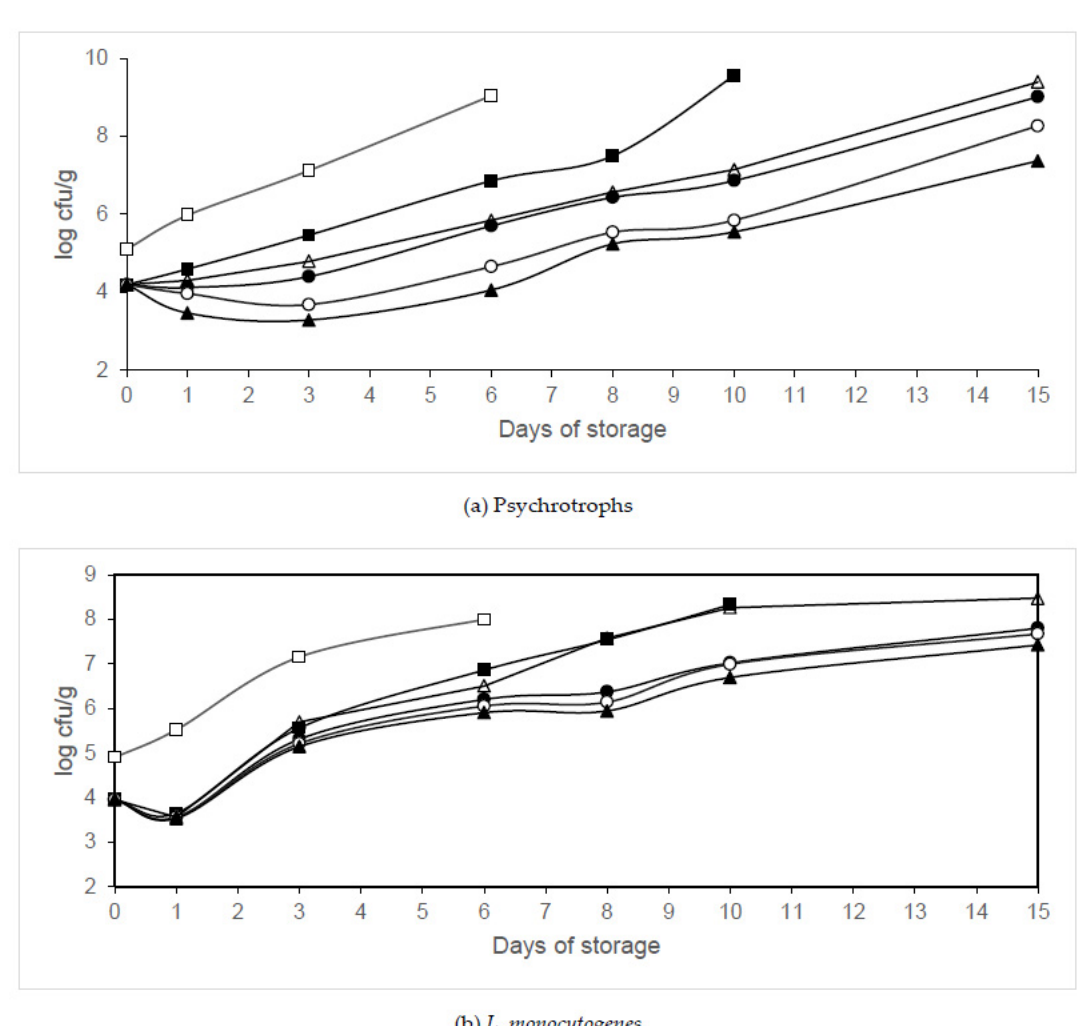
Figure 7. Changes in psychrotroph and L. monocytogenes counts in chicken legs treated with acetic acid and packaged under MAP. Treatment conditions: Batch C, distilled water and packaging in air ( □ ); Batch AA, 2% acetic acid and packaging in air ( ▪ ); Batch AAM20, 2% acetic acid and packaging in 80% N 2 /20% CO 2 ( • ); Batch AAM40, 2% acetic acid and packaging in 60% N 2 /40% CO 2 ( ◦ ); Batch AAM60, 2% acetic acid and packaging in 40% N 2 /60% CO 2 ( ▲ ); Batch AAV, 2% acetic acid and packaging under vacuum ( Δ ). (a) Psychrotrophs. (b) L. monocytogenes. Data shown are each the mean value of six determinations.